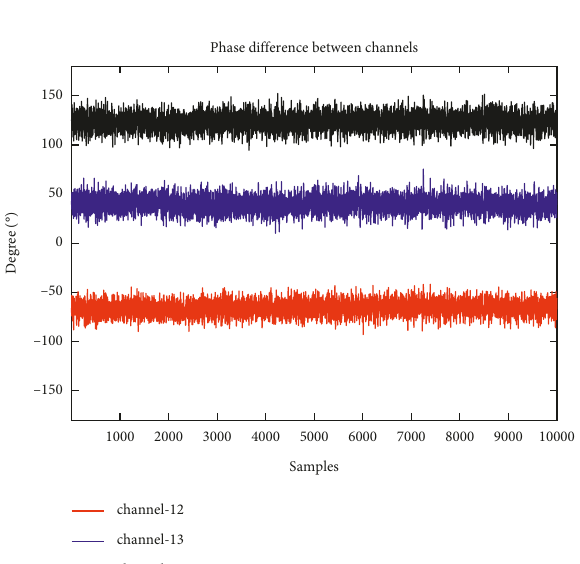
Figure 10: Synchronization error.